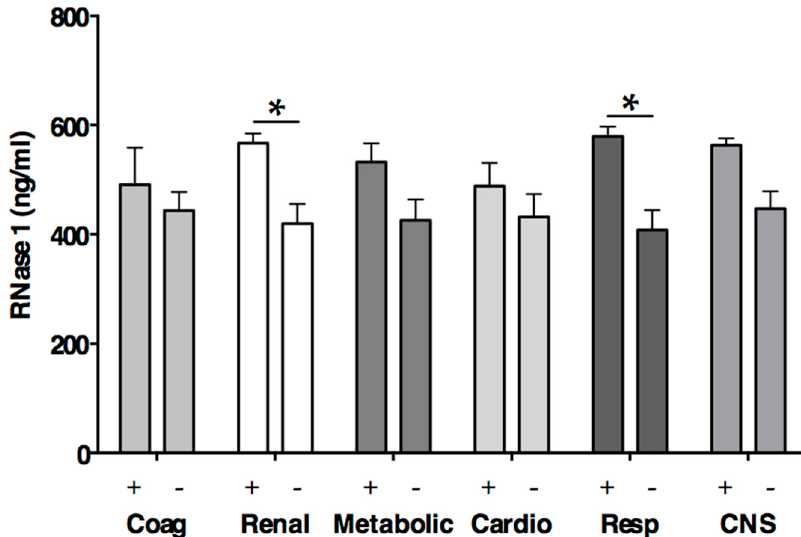
Figure 3. RNase 1 levels according to organ dysfunctions defined by the Surviving Sepsis Campaign [40]. Mean ± standard deviation. * p < 0.05; Coag Coagulation; Cardio Cardiovascular; Resp Respiratory; CNS Central nervous system; Plus (+) denotes presence of organ dysfunction; Minus ( − ) denotes absence of organ